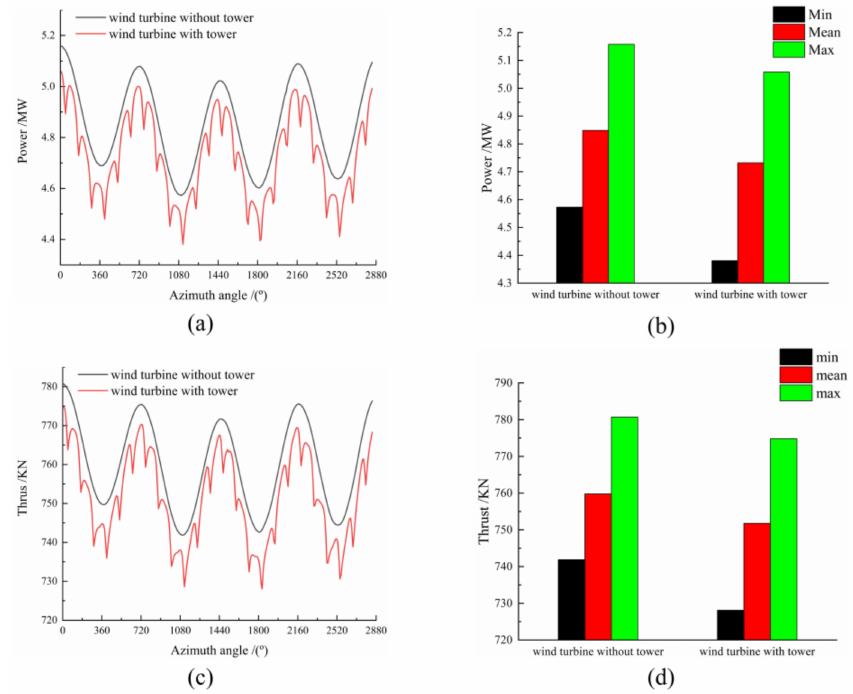
Figure 19. Total aerodynamic comparison of yaw motion; ( a ) Power versus azimuth angle; ( b ) Ex- treme and average values of power; ( c ) Thrust versus azimuth angle; ( d ) Extreme and average values of